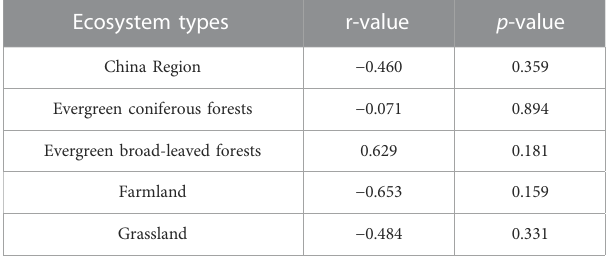
TABLE 2 Correlation between AOT40 and NPP for each ecosystem, 2014 – 2019. Ecosystem types